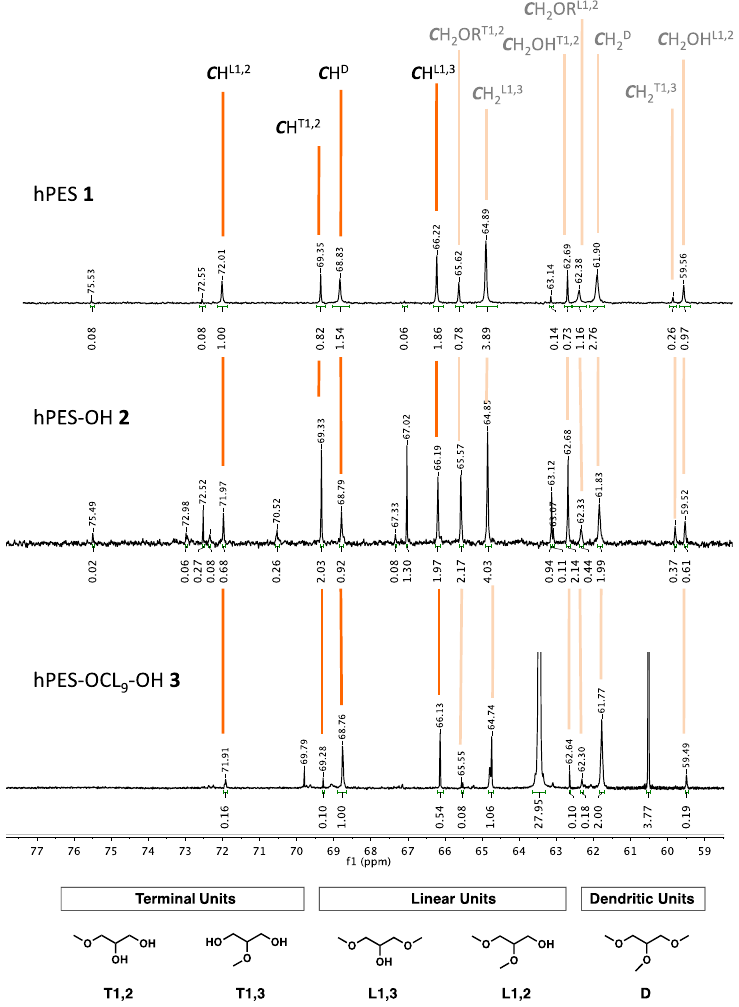
Figure A9. Details of 13 C NMR spectra of hPES 1 , hPES–OH 2 , and hPES–OCL 9 –OH 3 ( top to bottom ). Depicted are peaks relevant for calculation of D f and DB analysis. Five types of glycerol units can be distinguished in the structure of the hyperbranched polyester. For comparability of signal integrals, the value for diacid peaks was set to be identical in hPES 1 and hPES–OH 2 .